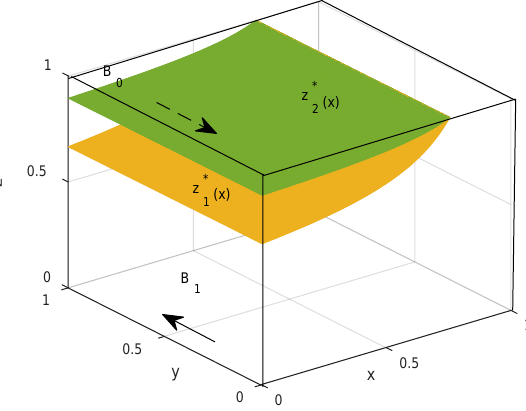
Figure 6. Behavior evolution direction of a construction enterprise under the tax mechanism.